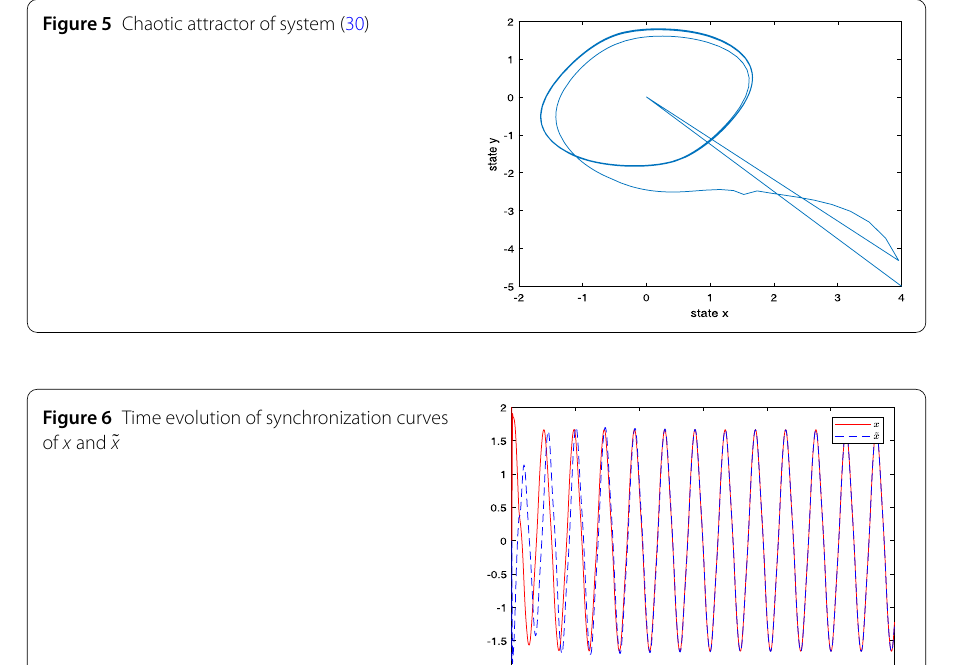
Figure 5 Chaotic attractor of system (30)